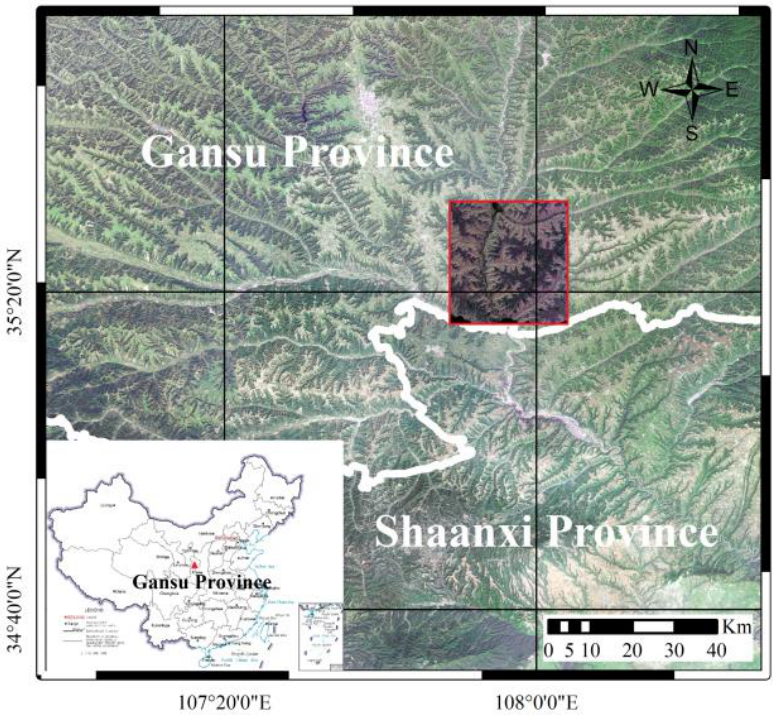
Figure 8. Geographic location of the study area.